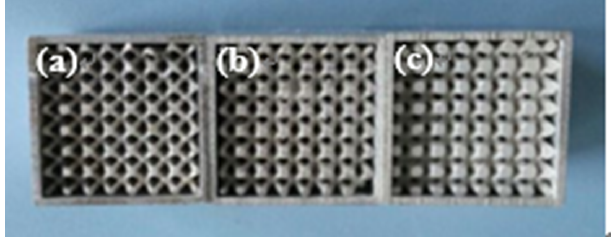
Figure 2. Pyramid lattice material-filled tube with different relative densities of lattice material: ( a ) 0.28; ( b ) 0.33; ( c ) 0.41.